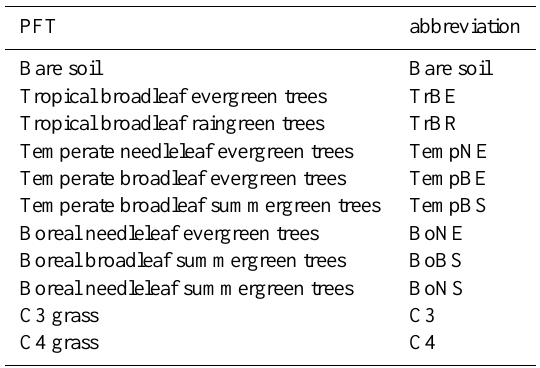
Table 1. Surface types in ORCHIDEE and abbreviations used in this paper. PFT abbreviation Bare soil Bare soil Tropical broadleaf evergreen trees TrBE Tropical broadleaf raingreen trees TrBR Temperate needleleaf evergreen trees TempNE Temperate broadleaf evergreen trees TempBE Temperate broadleaf summergreen trees TempBS Boreal needleleaf evergreen trees BoNE Boreal broadleaf summergreen trees BoBS